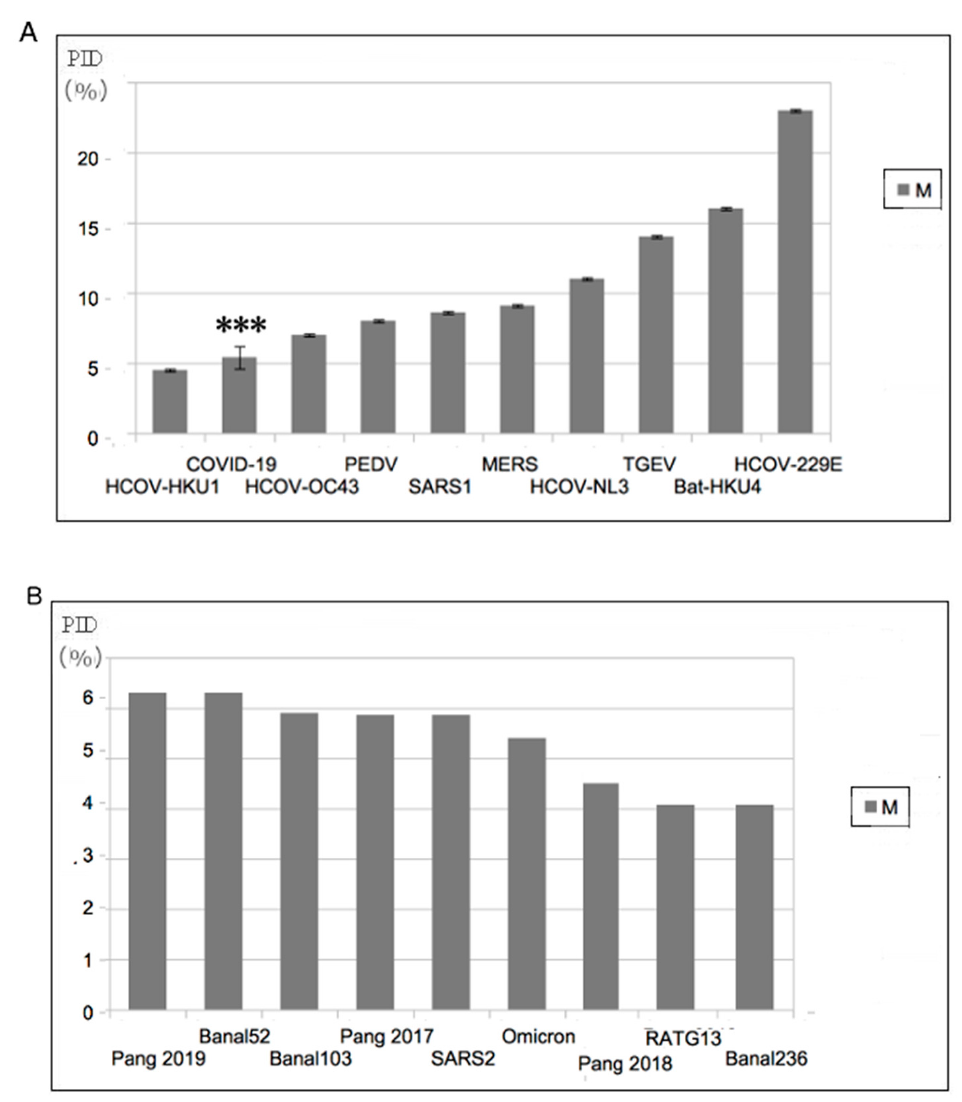
Figure 1. Abnormally Hard Outer Shell (Low PID M ) of COVID-19-Related Viruses ( A ) All known COVID-19 viruses have among the hardest outer shells within the CoV family. “***” refers to SARS- CoV-2. ( B ) Comparison of PID M values among COVID-19 related viruses. A relatively harder M can be found in Omicron. The label “SARS2” in ( B ) refers to all non-Omicron SARS-CoV-2 variants currently known. (Taken in part from Biomolecules. 2022;12(5). © 2022 Goh et al, Published by MDPI AG, Open access under CC BY-NC-ND license. This is an Open Access article which permits unrestricted non-commercial use, provided the original work is properly cited.